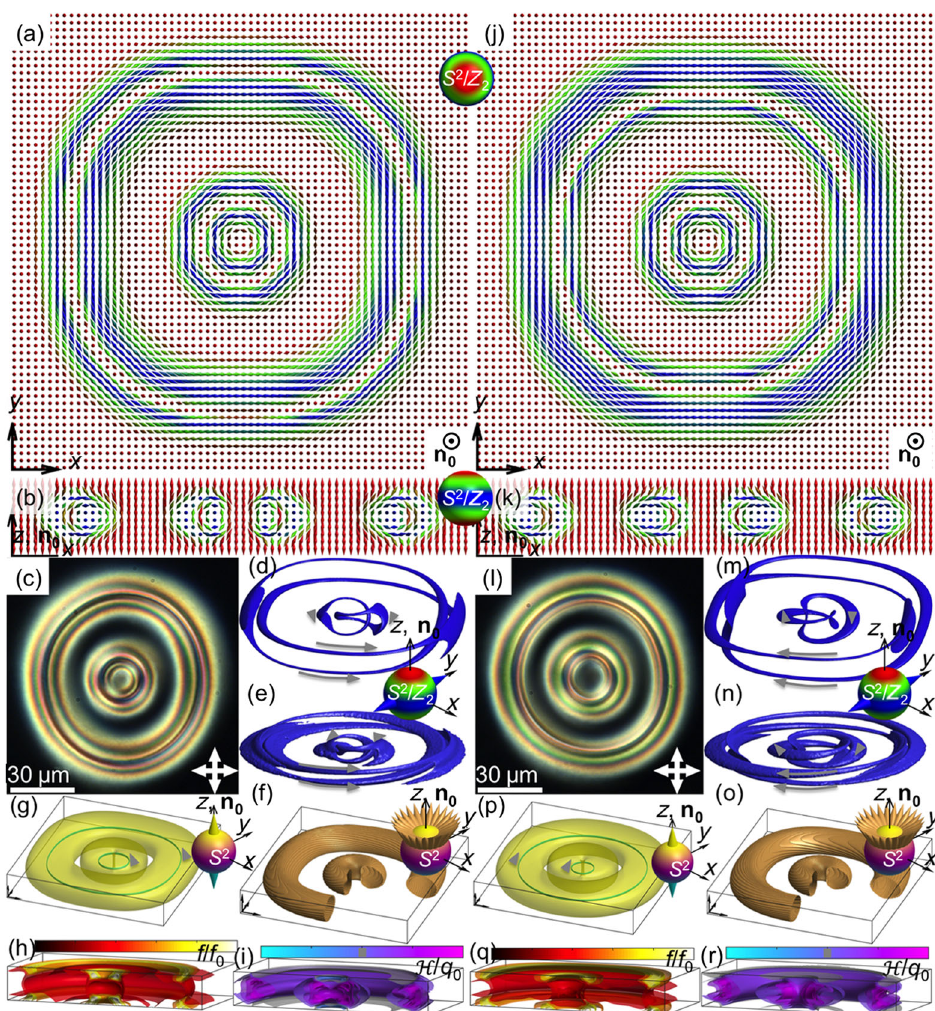
FIG. 6. 3D topological solitons formed by coaxial arrangement of two different elementary hopfions of the same signs Q ¼ (cid:2) 1 . (a), (b) Computer-simulated (a) in-plane orthogonal to n 0 and (b) vertical containing n 0 cross sections of the axially symmetric n ð r Þ structure of a soliton with two-loop preimages depicted using colored double cones; the color scheme establishes the correspondence between director orientations and the points on S 2 =Z 2 (top right insets). (c) A polarizing optical micrograph of such a 3D soliton in a confined chiral nematic LC; white double arrows show crossed polarizers. (d) Computer-simulated and (e) experimental preimages of the soliton for the diametrically opposite points on S 2 =Z 2 marked by double cones in the right-hand side inset. By analyzing such preimages of all points on S 2 =Z 2 , we find no interlinking between the preimages of the two separate hopfions and their Hopf indices Q ¼ 1 . (f) For a constant polar angle value (inset), the closed-loop preimages of individual points on S 2 tile into two separate tori surfaces sharing the same vertical axis parallel to n 0 . (g) Preimages of the north and south poles of S 2 for the vectorized director field. (h), (i) Perspective views of the 3D computer-simulated isosurfaces of normalized (h) handedness and (i) free-energy density for this axially symmetric soliton, with the corresponding color schemes shown in the insets above them. (j), (k) Computer-simulated (j) in-plane and (k) vertical cross sections of an axially symmetric n ð r Þ structure of a soliton with two-loop preimages depicted using colored double cones and the same color scheme as in (a),(b) that establishes the correspondence between director orientations and the S 2 =Z 2 points. (l) A polarizing optical micrograph of such a 3D soliton. (m) Computer-simulated and (n) experimental preimages of the hopfion for the diametrically opposite points on S 2 =Z 2 marked by double cones in the right-hand side inset. (o) For a constant polar angle value, the closed-loop preimages of the individual points on S 2 tile into two separate tori that share the vertical axis parallel to n 0 . By analyzing preimages of all points on S 2 =Z 2 , we find no interlinking between the preimages of the two separate hopfions and also their Hopf indices Q ¼ − 1 . (p) Preimages of the north and south poles of S 2 for the vectorized director field. (q), (r) Perspective views of the 3D computer-simulated isosurfaces of normalized (q) handedness and (r) free-energy density for this soliton, with the corresponding color schemes shown in the insets. Computer simulations are performed for elastic constants of 5CB while also assuming K 24 ¼ 0 . The polarizing optical micrographs in (c) and (l) are obtained for structures in a 5CB-based partially polymerizable nematic LC mixture with a chiral additive CB-15 in a cell with thickness d ¼ 10 μ m and d=p ∼ 1 . Gray arrows in (d), (e), (m), (n), (g), and (p) indicate the consistently determined circulations of the preimages. The 3D preimages are reconstructed based on 3PEF-PM images of these structures after the unpolymerized 5CB is replaced by immersion